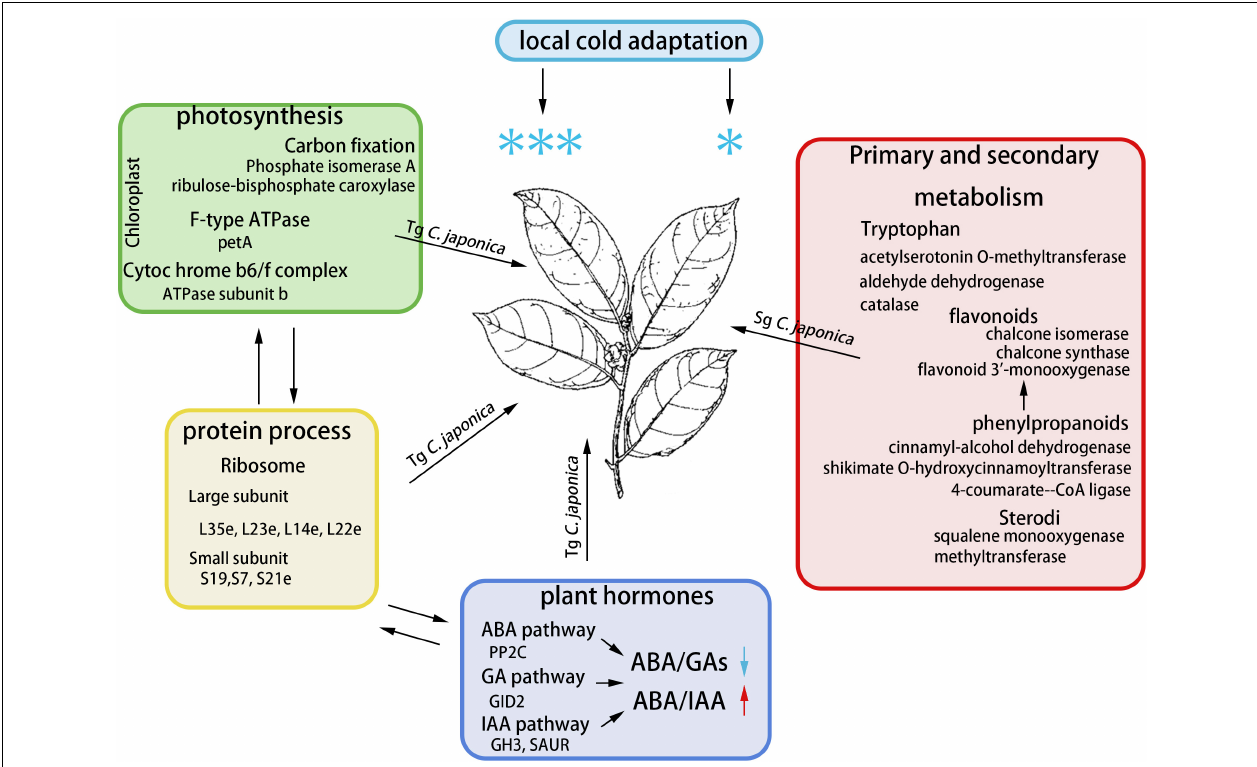
FIGURE 7 | Molecular mechanism module for the response to cold in C. japonica . We have integrated the potential pathways and genes involved in cold resistance divergence.